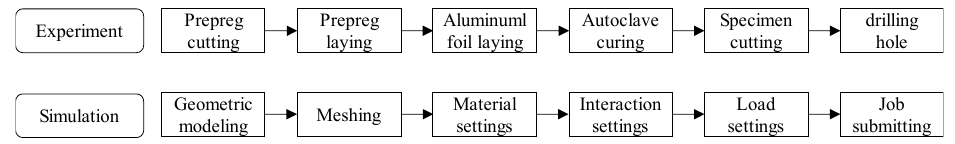
Figure 1. Scheme of experiment and simulation.